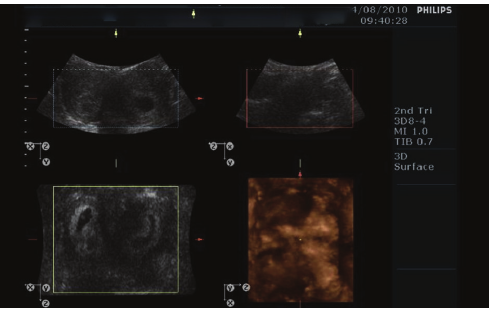
Figure 1: Two embryos were located in separate cavities of the bicornuate uterus.